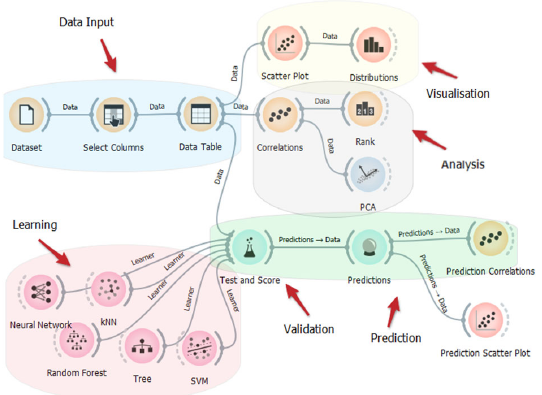
Figure 12. Example of the Orange workflow for data mining.